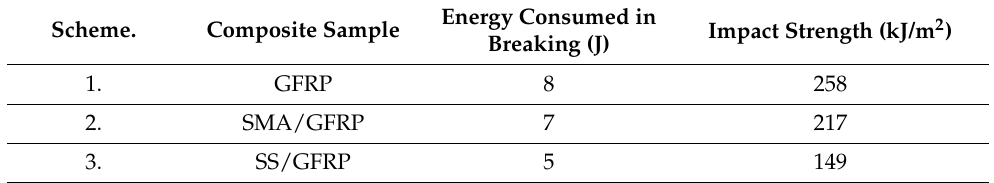
Table 2. Results of Charpy Impact Test set A. Scheme.